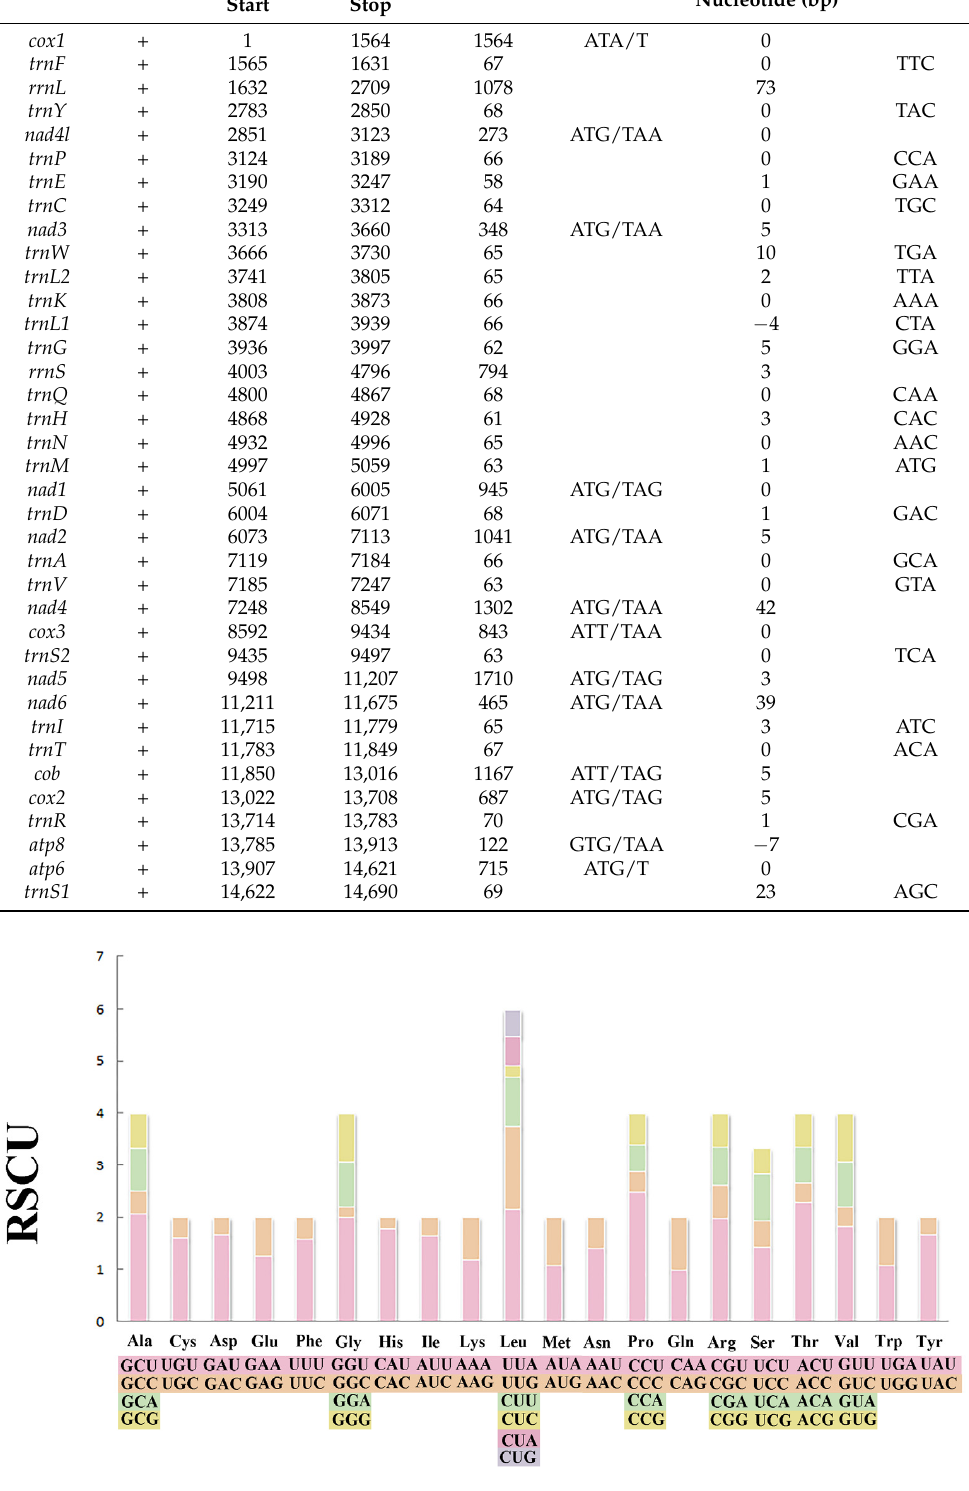
Figure 3. Relative synonymous codon usages (RSCU) in the mitogenomes of M. virgata . Table 3. The codon number and relative synonymous codon usage in the mitochondrial genomes of M. virgata . The asterisk (*) in the table indicates the stop codon.